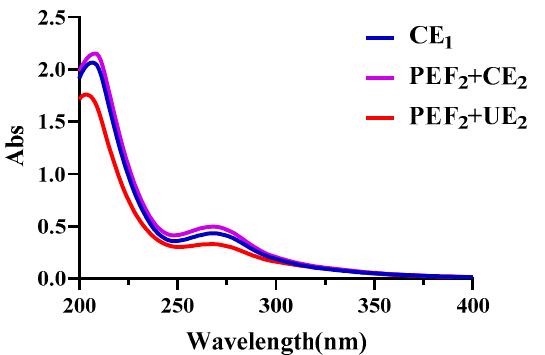
Figure 6. The UV − vis spectra of Se − TPSs obtained using different extraction methods and studied in the range of 200~400